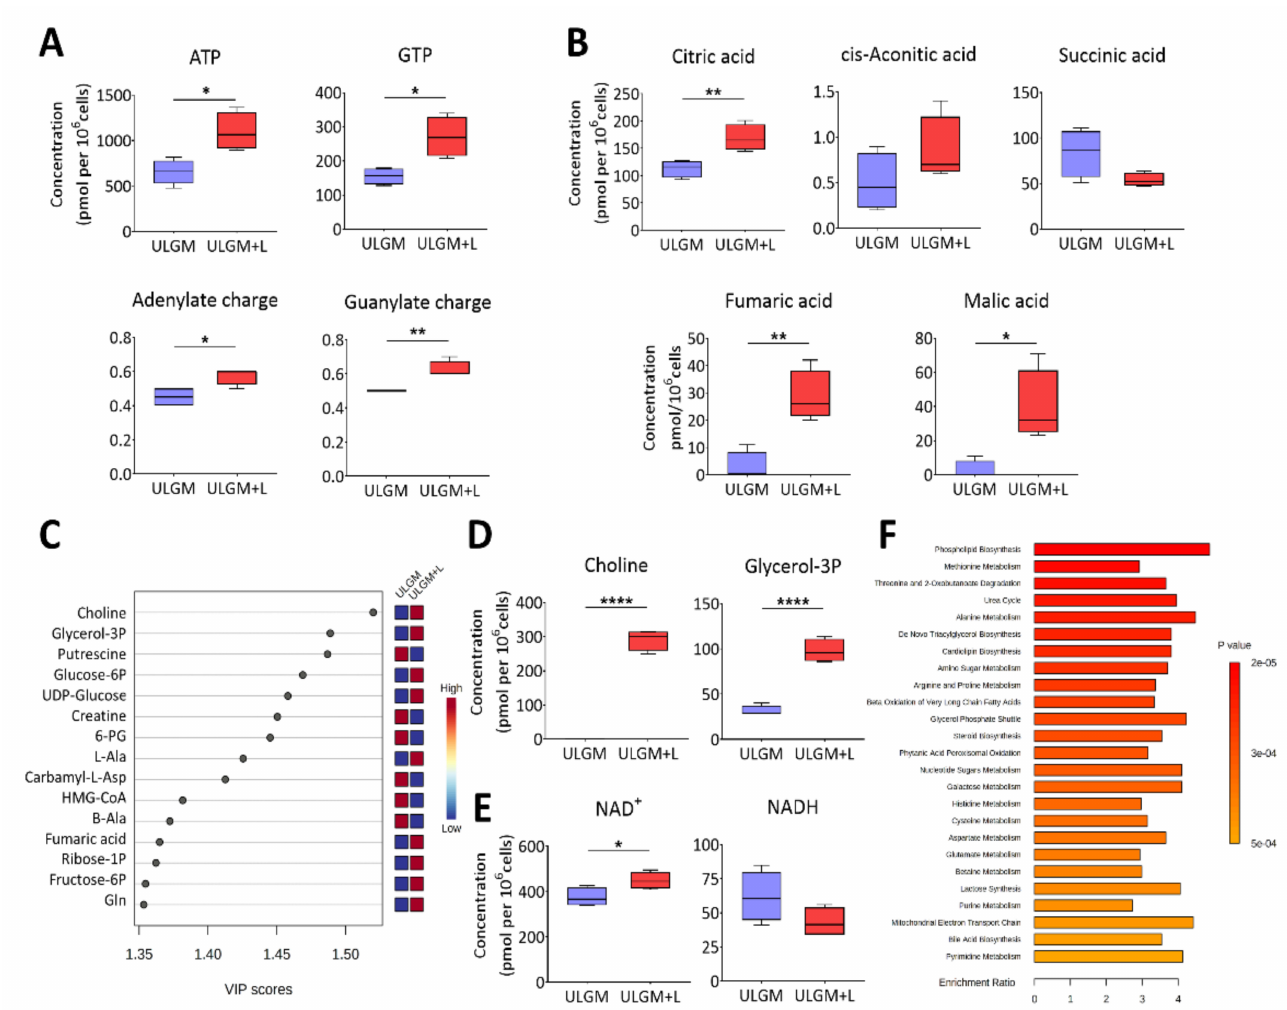
Figure 4. Lactate reprograms catabolic processes in glucose-deprived GSCs. ( A ) Metabolomics analysis of ATP and GTP as well as adenylate charge and guanylate charge in TSH-N5 cells cultured for 6 days in ULGM with or without 4 mM lactate. Data are presented as box-and-whisker plots, in which the boxes indicate the median and upper and lower quartile values, and the whiskers represent the highest and lowest nonoutlier values. ( B ) Concentrations of TCA cycle intermediates determined as in ( A ). ( C ) VIP (variable importance in projection) scores as determined by partial least squares–discriminant analysis (PLS-DA) for metabolites in cells as in ( A ). ( D , E ) Levels of choline and glycerol 3-phosphate ( D ) as well as of NAD + and NADH ( E ) for cells as in ( A ). ( F ) Top 25 metabolite sets that differed significantly between ULGM and ULGM+L and their enrichment ratios. Metabolite levels were determined by capillary electrophoresis and mass spectrometry, normalized by cell number, and are from four biologically distinct replicates per condition. For PLS-DA and Metabolite Set Enrichment Analysis, data were scaled by mean-centering followed by division by the SD for each variable. * p < 0.05, ** p < 0.01, **** p < 0.0001 (unpaired two-tailed Student’s t